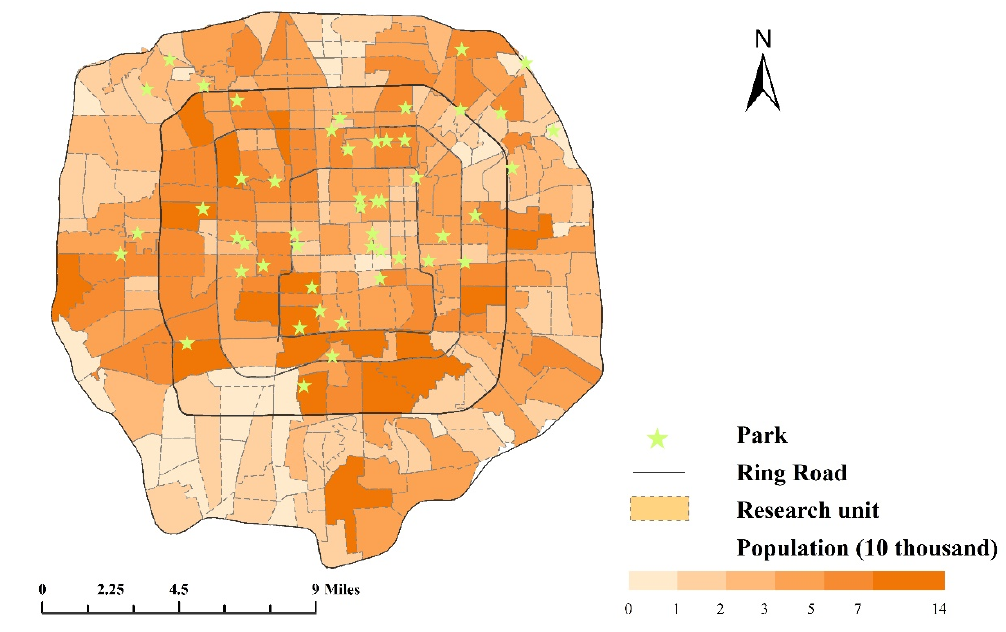
Figure 3. The research unit, parks and TAZ population.